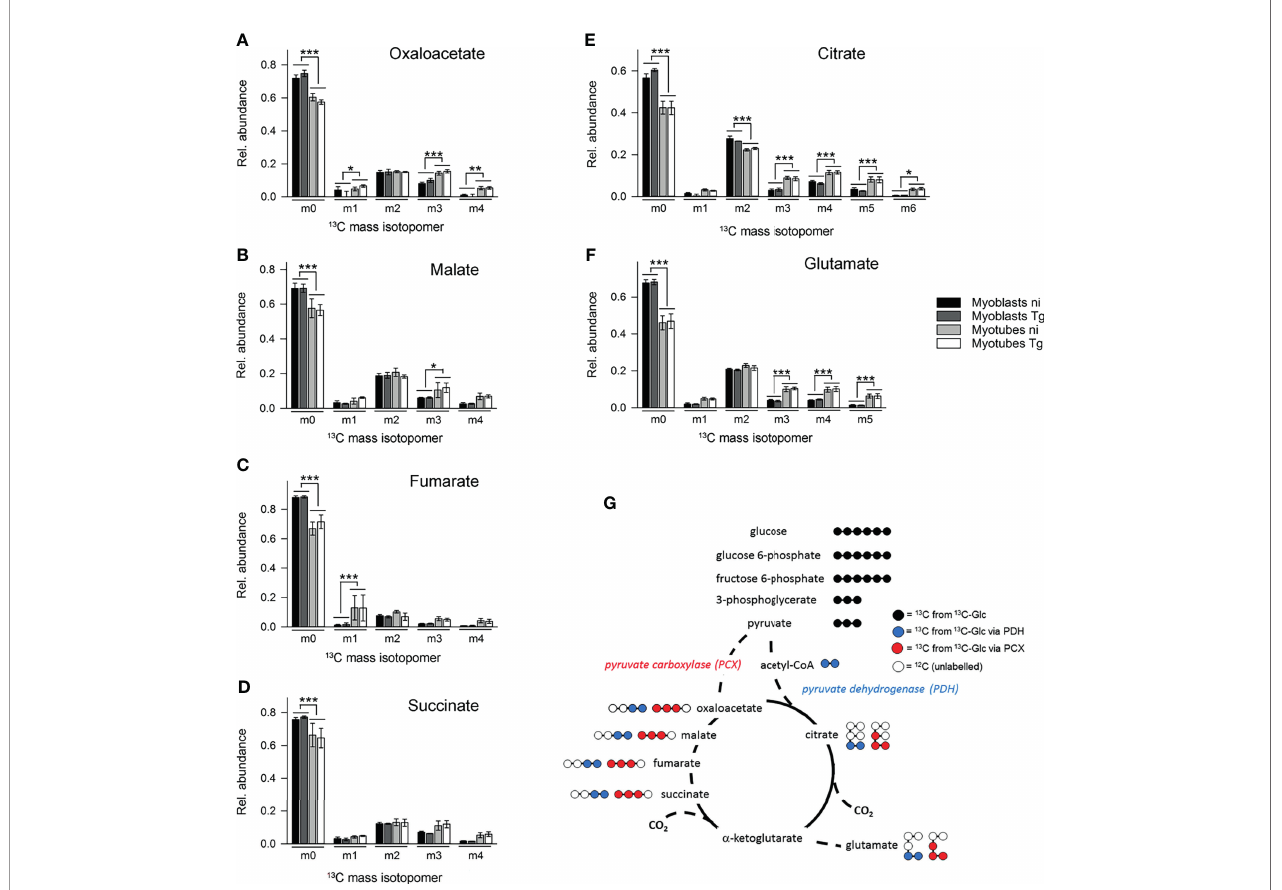
FIGURE 5 | Myotubes during infection with T. gondii channel more glycolytic glucose via the pyruvate carboxylase into the TCA cycle than myoblasts. C2C12 myoblasts and in vitro -differentiated myotubes were infected with T. gondii for 6 hours or were left non-infected and were then incubated in complete medium containing 13 C-U-glucose for 4 hours. (A – F) The molar ratio of mass isotopologues (m0-m6) of different TCA cycle intermediates and glutamate are indicated. Bars represent means ± S.E.M. from three independent experiments; signi fi cant differences were identi fi ed by ANOVA (* p < 0.05; ** p < 0.01; *** p < 0.001). (G) Schematic of the number of 13 C atoms in metabolites derived from 13 C-U-glucose catabolized through glycolysis (black) and channeled into the TCA cycle either via the PCX (red) or the PDH